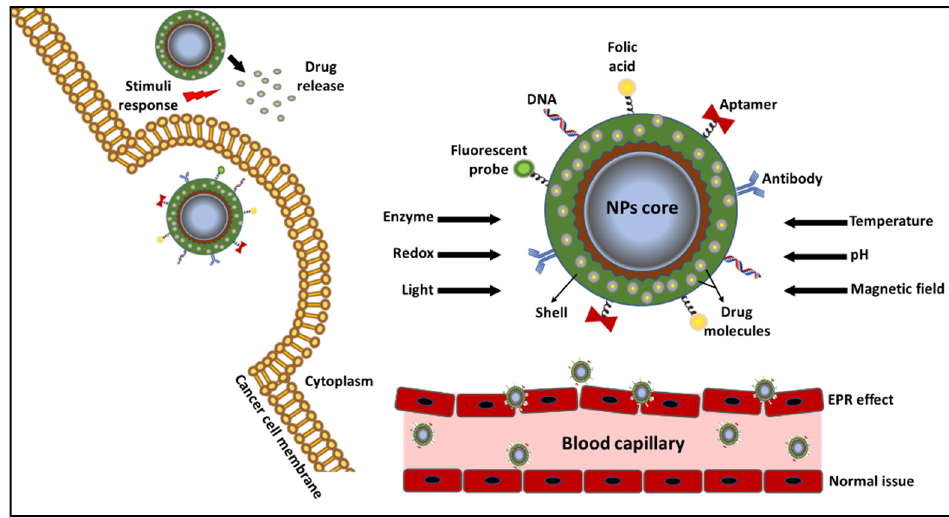
Figure 3. methodology of Anti-cancer therapy. Figure 3. Methodology of Anti-cancer